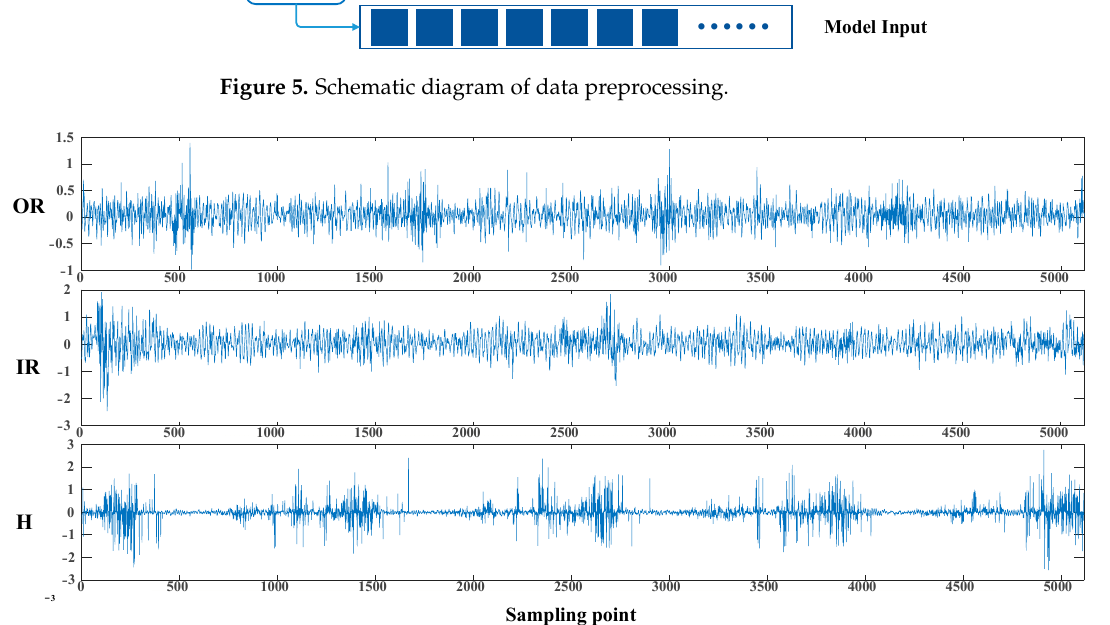
Figure 6. Signal segments with different health conditions in Case 1. OR denotes outer race fault, IR denotes inner race fault and H represents the healthy sample.